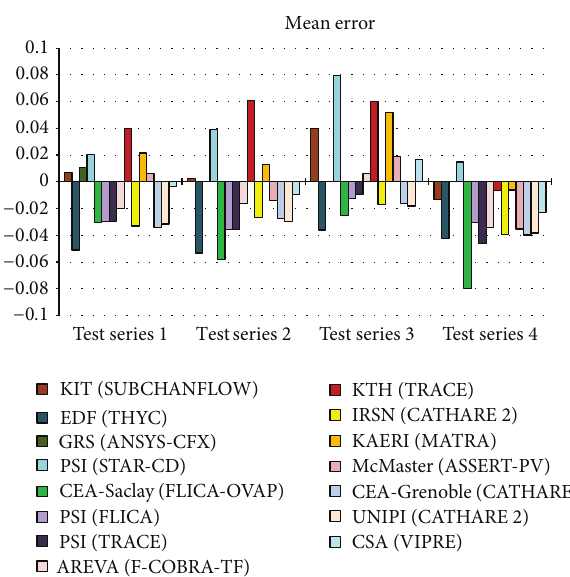
Figure 19: Deviation of measured quality from recalculated quality for test series 7.